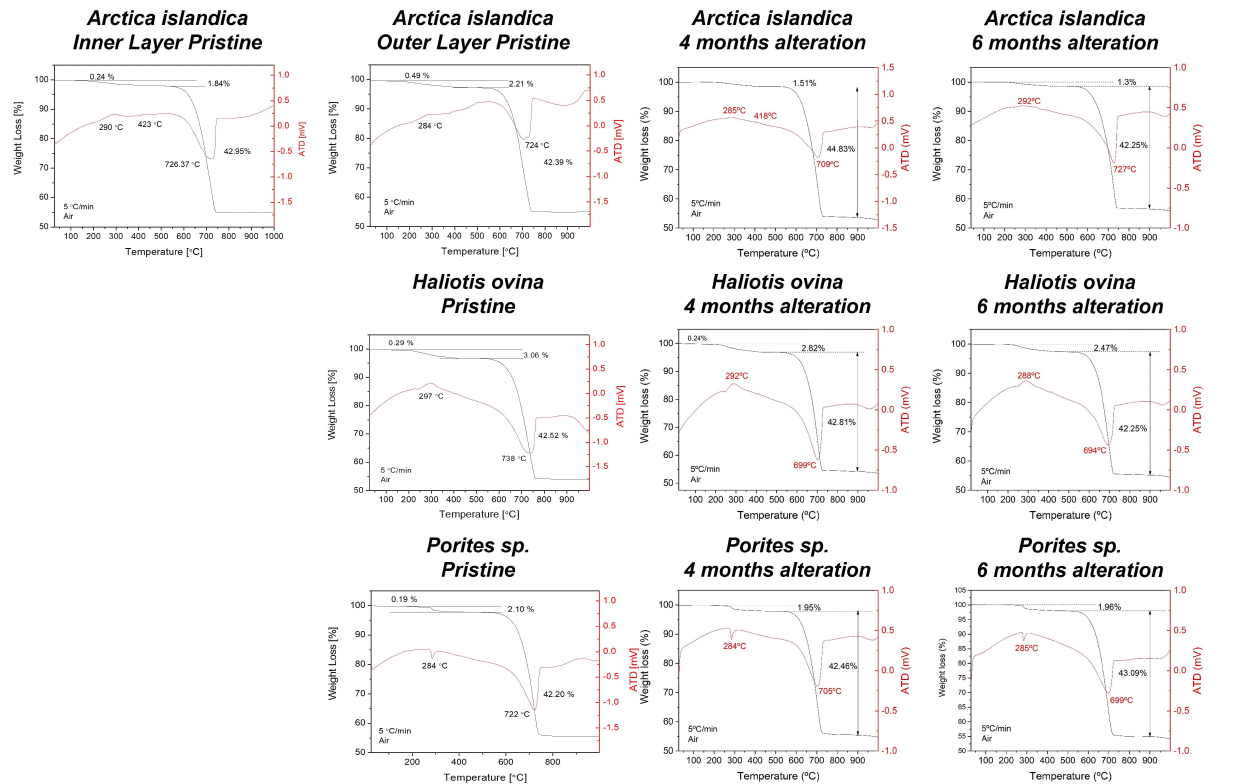
Figure A3. Thermogravimetric analysis data of pristine and altered hard tissues of Arctica islandica , Haliotis ovina , and Porites sp. shells and skeletal elements. Alteration was performed at 80 ◦ C in a Mg-rich, burial-mimicking fluid (100mM NaCl + 10mM MgCl 2 ) and lasted for 4 and 6